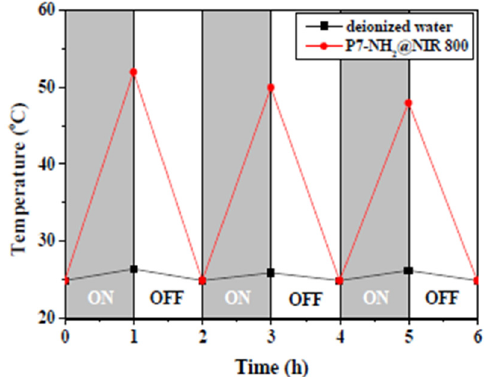
Figure 7. Temperature change curves of P7-NH 2 @NIR 800 micelles and deionized water under exposure to the NIR light ( λ max = 810 nm, 0.028 W / cm 2 ). ‘ON’ means the NIR light is on; ‘OFF’ means the NIR light is OFF.